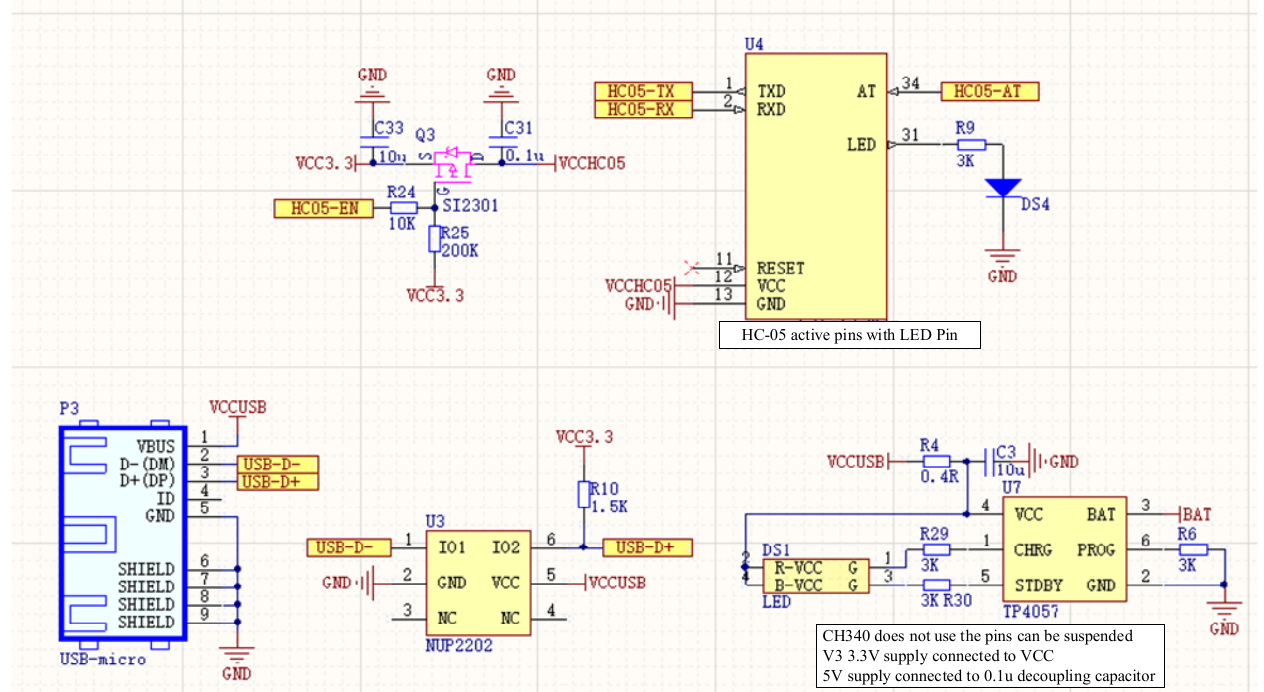
Figure 4. Bluetooth module and power circuit.